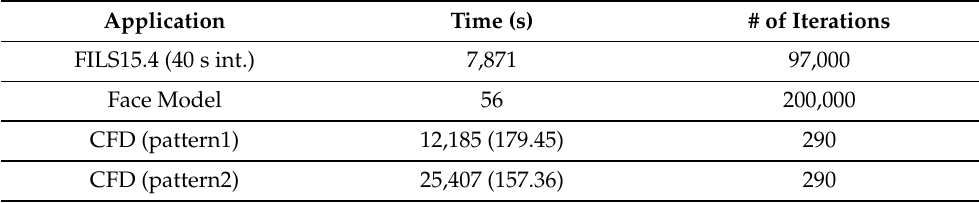
Table 15. CPU time